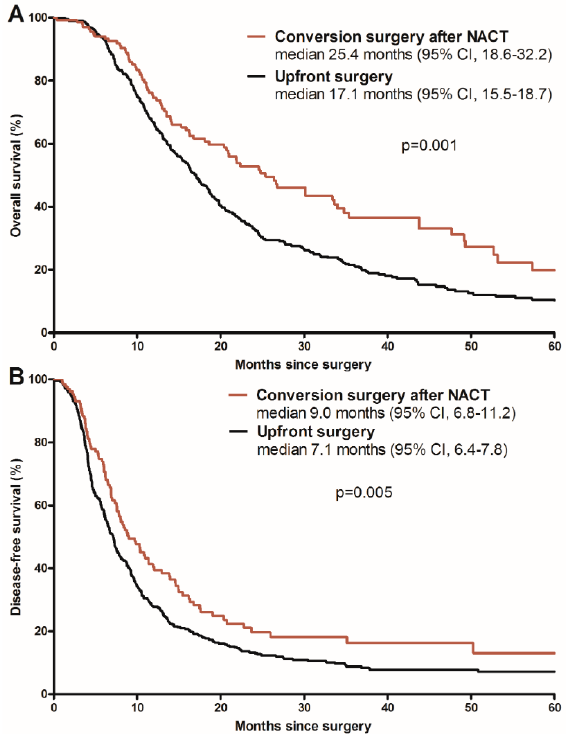
Figure 3. Comparison of overall survival ( A ) and disease-free survival ( B ) between patients undergoing